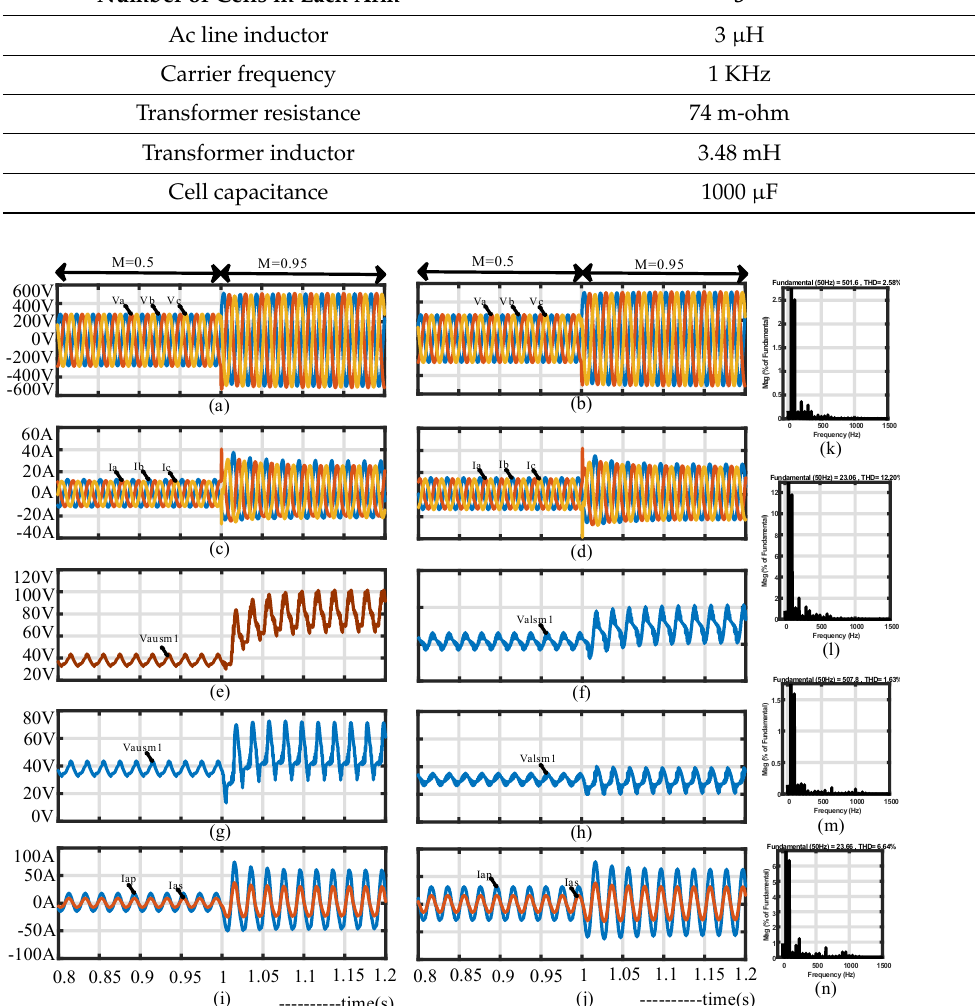
Figure 10. Change in modulation index. ( a ) Line voltages of converter with d-q control and SPWMLSC, ( b ) line voltages of converter with d-q control and SPWMPSC, ( c ) Line currents of con- verter with d-q control and SPWMLSC, ( d ) line currents of converter with d-q control and